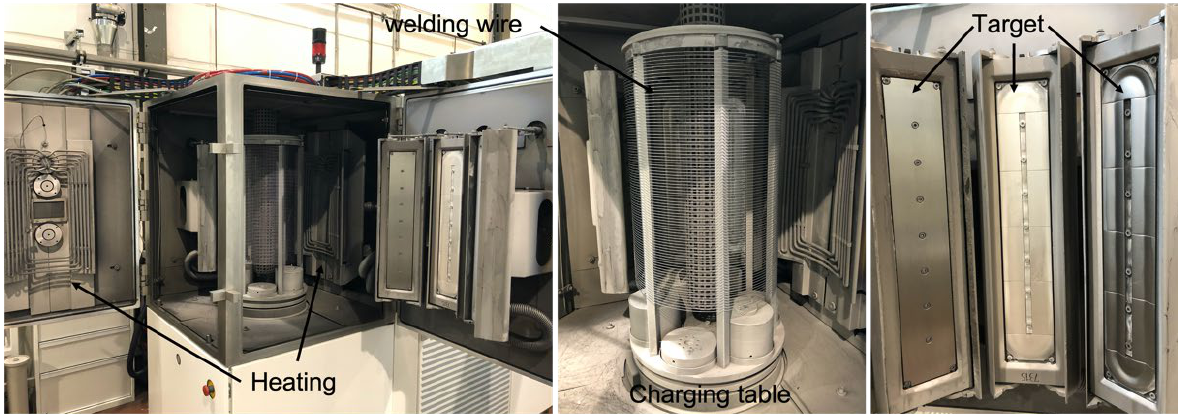
Figure 2. PVD system.